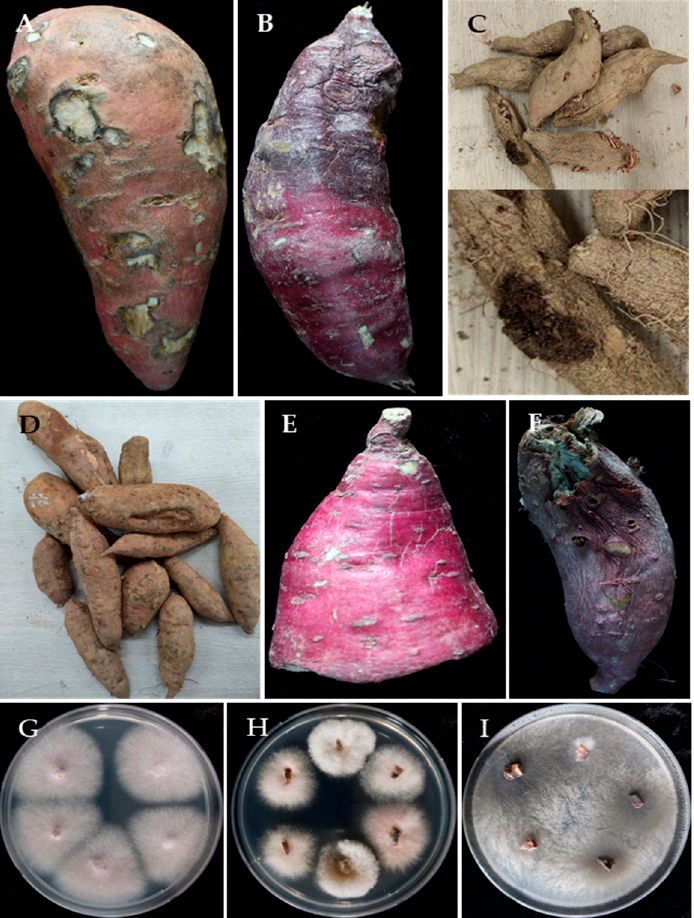
Figure 1. Symptoms of sweet potato postharvest diseases collected from local markets in Korea: ( A ) Fusarium surface rot, ( B ) charcoal rot, ( C ) Aspergillus mold, ( D ) surface rot, ( E ) end rot, and ( F ) Penicillium mold. The surface sterilized storage root tissues of Fusarium rot, charcoal rot, and other diseases were placed on potato dextrose agar media containing antibiotics. Examples of fungal colonies grown from the tissues of Fusarium rot ( G , H ) and charcoal rot ( I ) are shown.